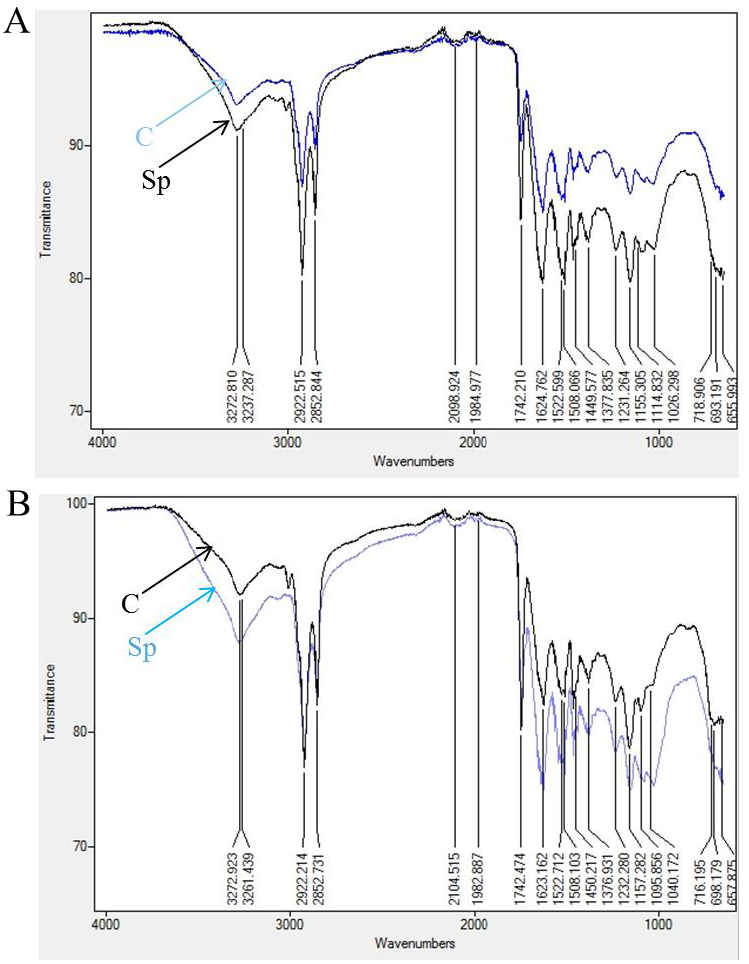
Figure 1. FTIR spectra of control (c) and Spirulina -fortified burgers made from barbel (A) and carp ( B